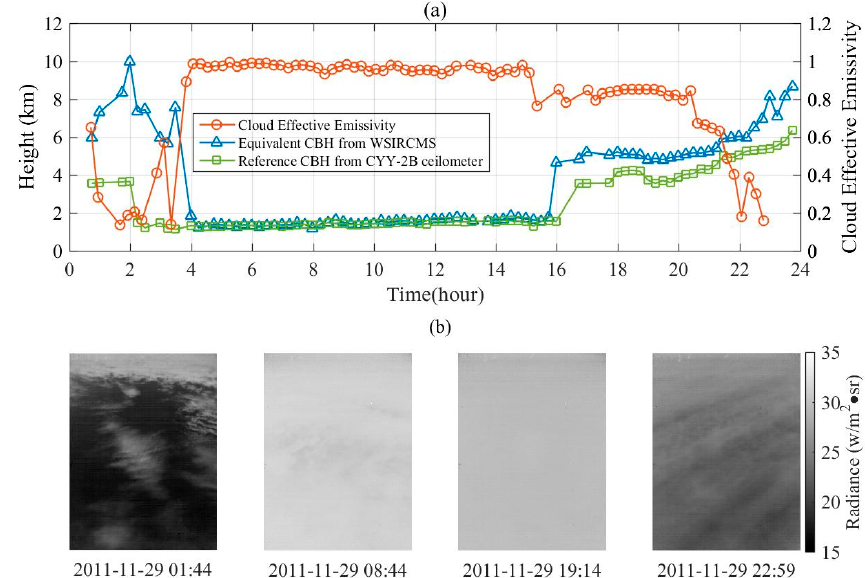
Figure 4. Example of the cloud effective emissivities derived from the joint observation ( a ) and corresponding images showing the zenith sky at 01:44, 08:44, 19:14, and 22:59 LT (from left to right) ( b ) at the CMA Beijing Observatory Station for 29 November 2011.